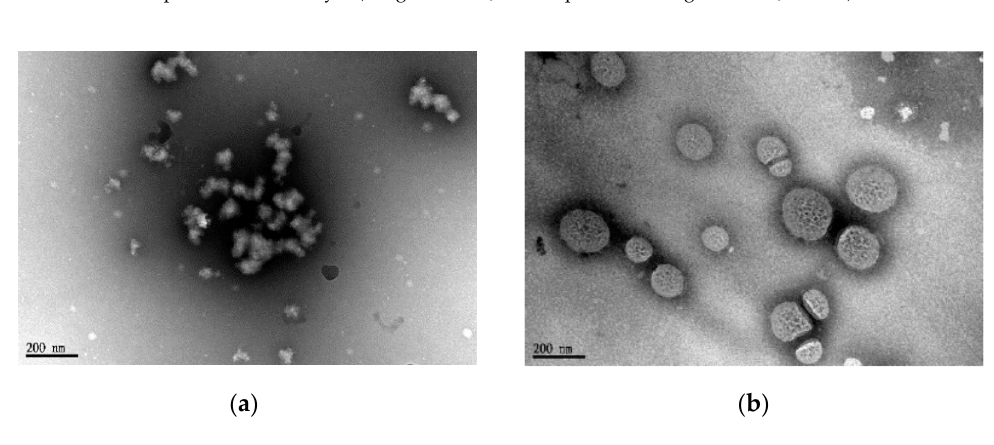
Figure 6. TEM images of ( a ) BD5 and ( b ) HBD5 polymeric nanoparticles.